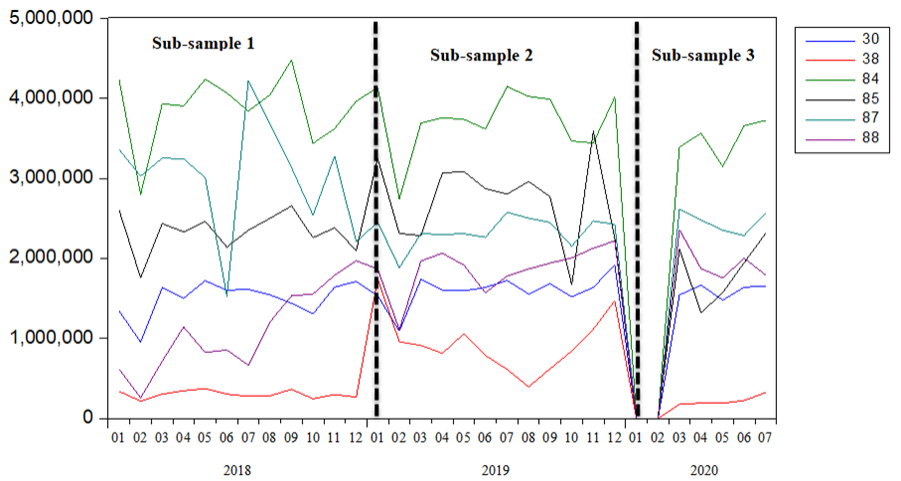
Figure 7. China import values ($) of the selected articles. Source: own investigation.